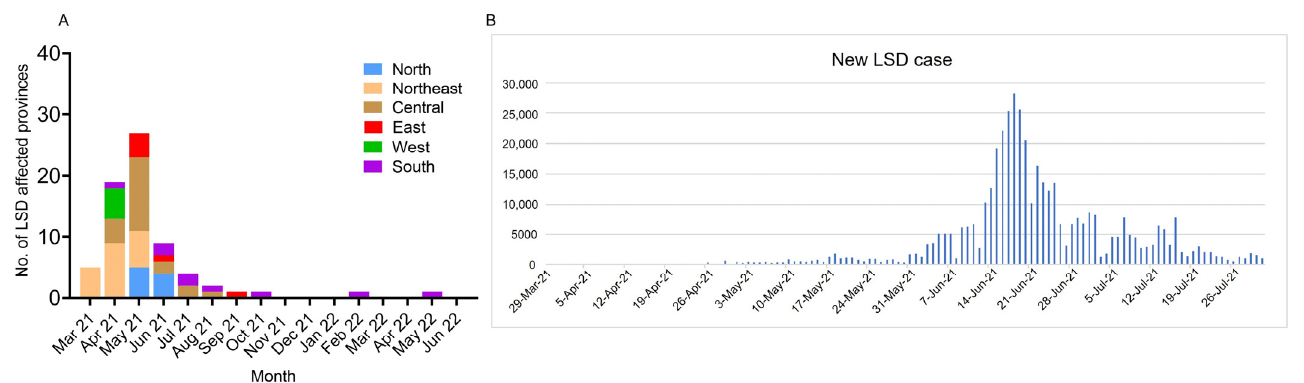
Figure 3. Number of reported LSD-affected provinces and cases during the first epidemics in Thai- land. ( A ) The bar chart shows the numbers of LSD-affected provinces from March 2021 to June 2022